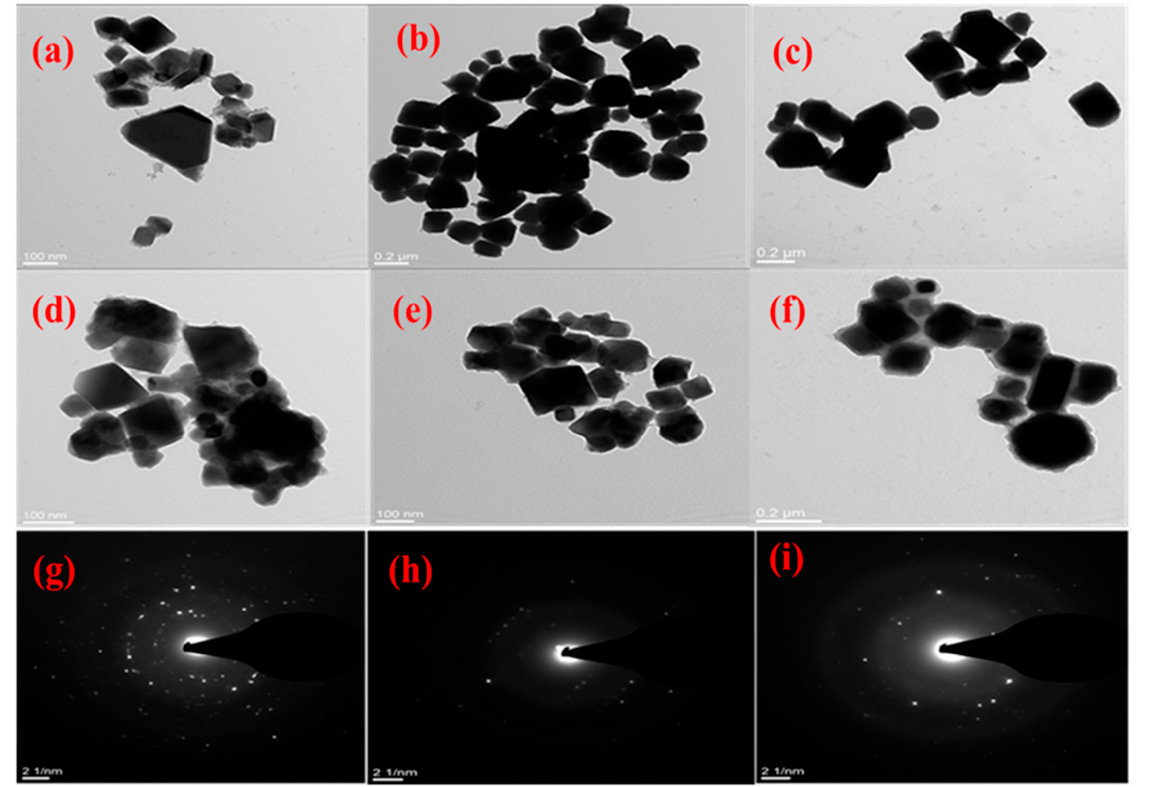
Figure 6. TEM images of Cu x S y nanoparticles prepared in ( a , d ) OLA, ( b , e ) HDA, and ( c , f ) DDA at 190 °C using complexes 1 and 2; SAED patterns of nanoparticles prepared in ( g ) OLA, ( h ) HDA, and ( i ) DDA at 230 °C from complex 1.